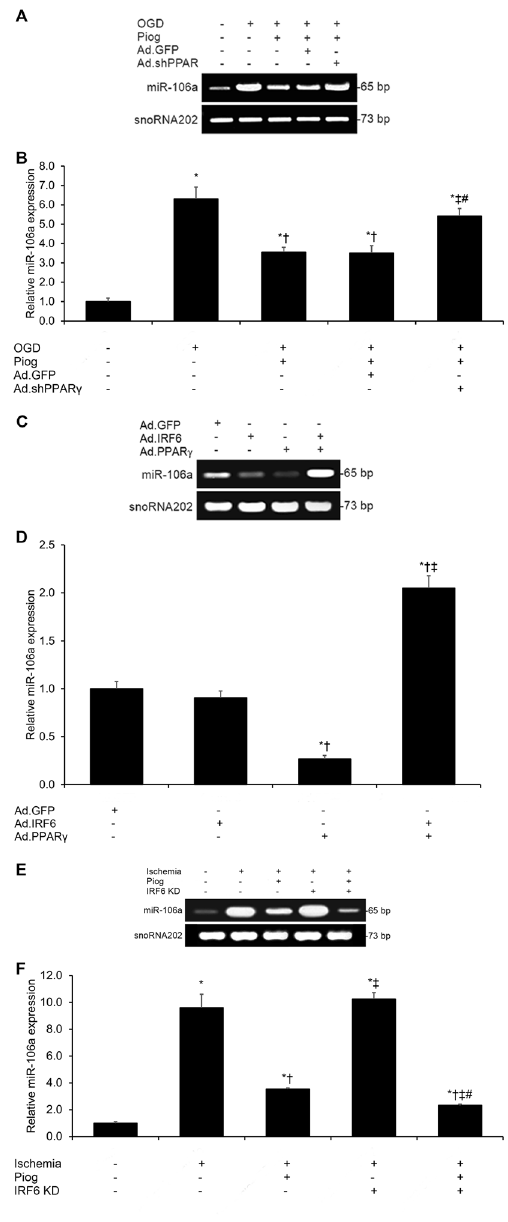
Figure 5. IRF6 Inhibits PPAR γ -Induced Repression of miR-106a Expression in Ischemic Cerebrovascular Endothelial Cells. ( A,B ) Control GFP and small-hairpin PPAR γ RNA (PPAR γ shRNA)-transfected murine cerebrovascular endothelial cells were pre-treated with pioglitazone prior to oxygen-glucose deprivation (OGD) exposure. Real-time PCR on the total RNA content from these cells revealed that OGD-induced miR- 106a upregulation was reversed by pioglitazone, and this effect was dependent upon PPAR γ . Cropped blots are displayed here. * P < 0.05 versus sham group, † P < 0.05 versus OGD group, ‡ P < 0.05 versus OGD + Piog group, # P < 0.05 versus OGD + Piog + Ad.GFP group. ( C,D ) Real-time PCR on the total RNA content from murine cerebrovascular endothelial cells transfected with adenoviral GFP, IRF6, PPAR γ , or IRF6 + PPAR γ revealed that PPAR γ gain-of-function significantly reduced miR-106a expression. IRF6 gain-of-function alone had no significant impact upon miR-106a expression, but it significantly inhibited PPAR γ suppression of miR- 106a expression. Cropped blots are displayed here. * P < 0.05 versus Ad.GFP group, † P < 0.05 versus Ad.IRF6 group, ‡ P < 0.05 versus Ad.PPAR γ group. ( E,F ) Wild-type mice or adenoviral-mediated IRF6 knockdown mice were treated with pioglitazone following middle cerebral artery (MCA) occlusion. After 24 hours of MCA reperfusion, cerebral microvessels were isolated. Real-time PCR on the total RNA content from these cerebral microvessels revealed that cerebral ischemia-induced miR-106a upregulation was reversed by pioglitazone. IRF6 knockdown alone had no significant impact upon miR-106a transcription, but IRF6 knockdown significantly promoted pioglitazone-driven PPAR γ suppression of miR-106a transcription. Cropped blots are displayed here. * P < 0.05 versus sham group, † P < 0.05 versus Ischemia group, ‡ P < 0.05 versus Ischemia + Piog group, # P < 0.05 versus Ischemia + IRF6 KD